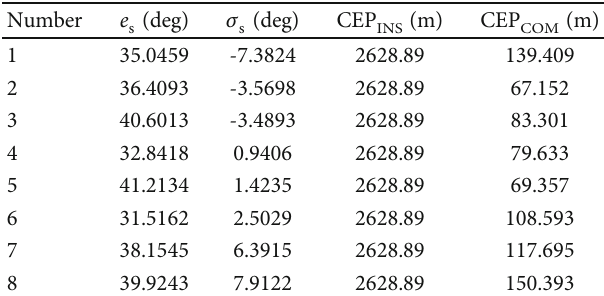
Table 4 represents the required time and the optimal navigation stars determined by the three methods. In the table, CEP INS is the pure inertial guidance accuracy, and CEP COM is the composite guidance accuracy.